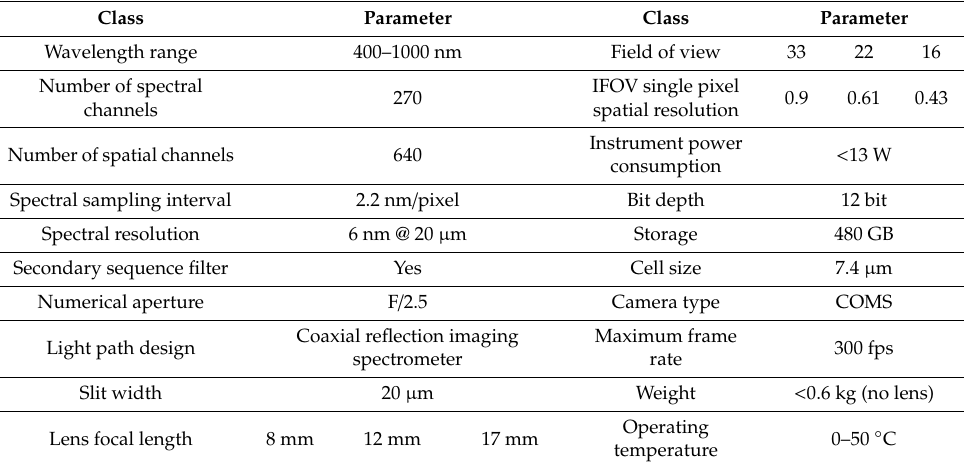
Table 1. Headwall NANO-Hyperspec technical parameters.